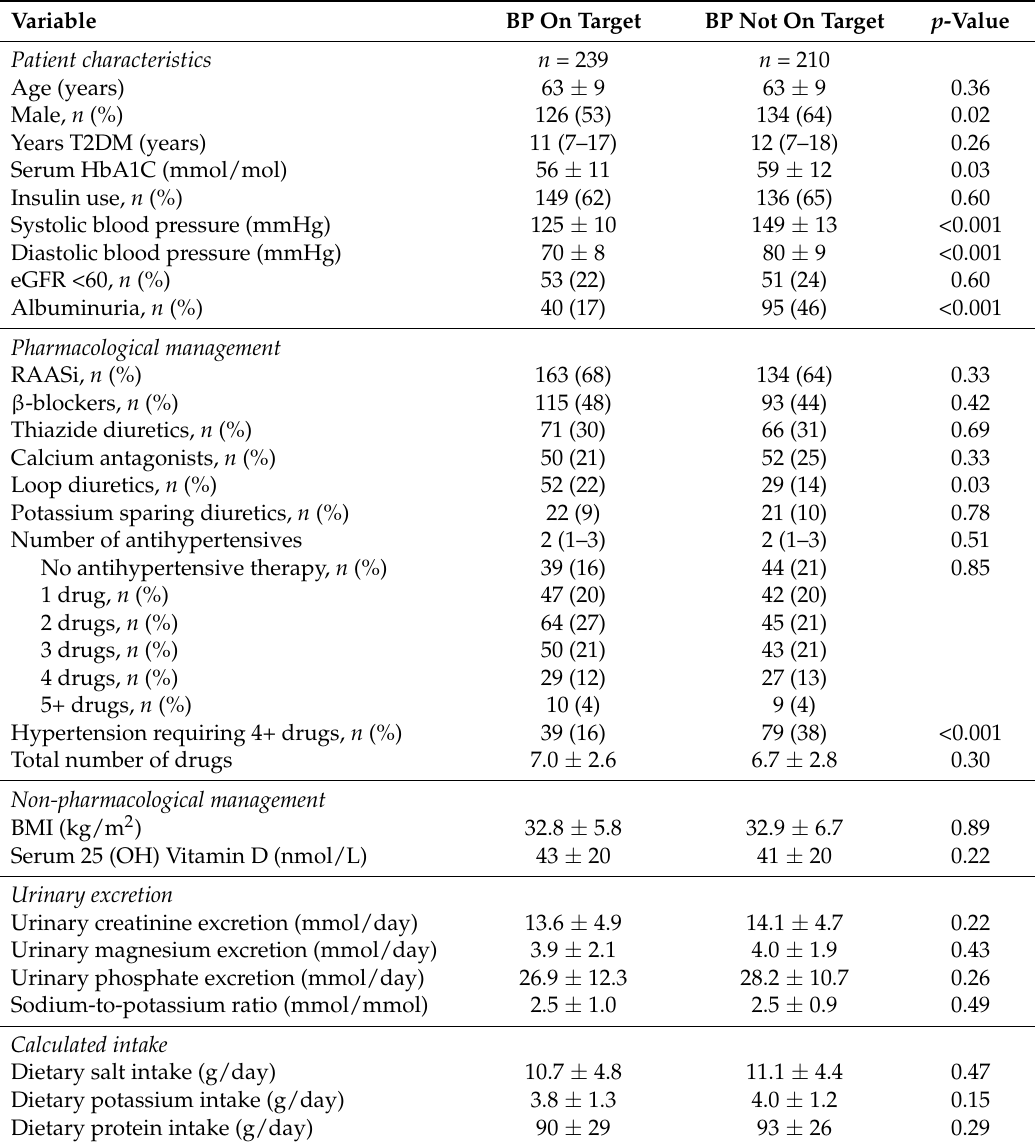
Table 2. DIALECT-1 pharmacological and nutritional management by a breakup of BP on target/not on